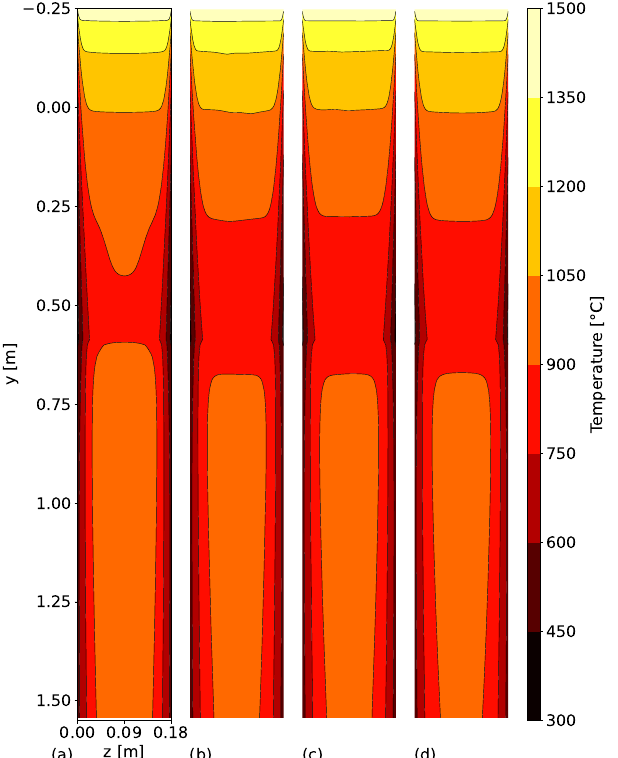
Figure 10. Temperature field at VA1. ( a ) k − ε model; steady-state; ( b ) LES model at t 1 = 205 s; ( c ) LES model at t 2 = 1096 s; ( d ) LES model; time-average.